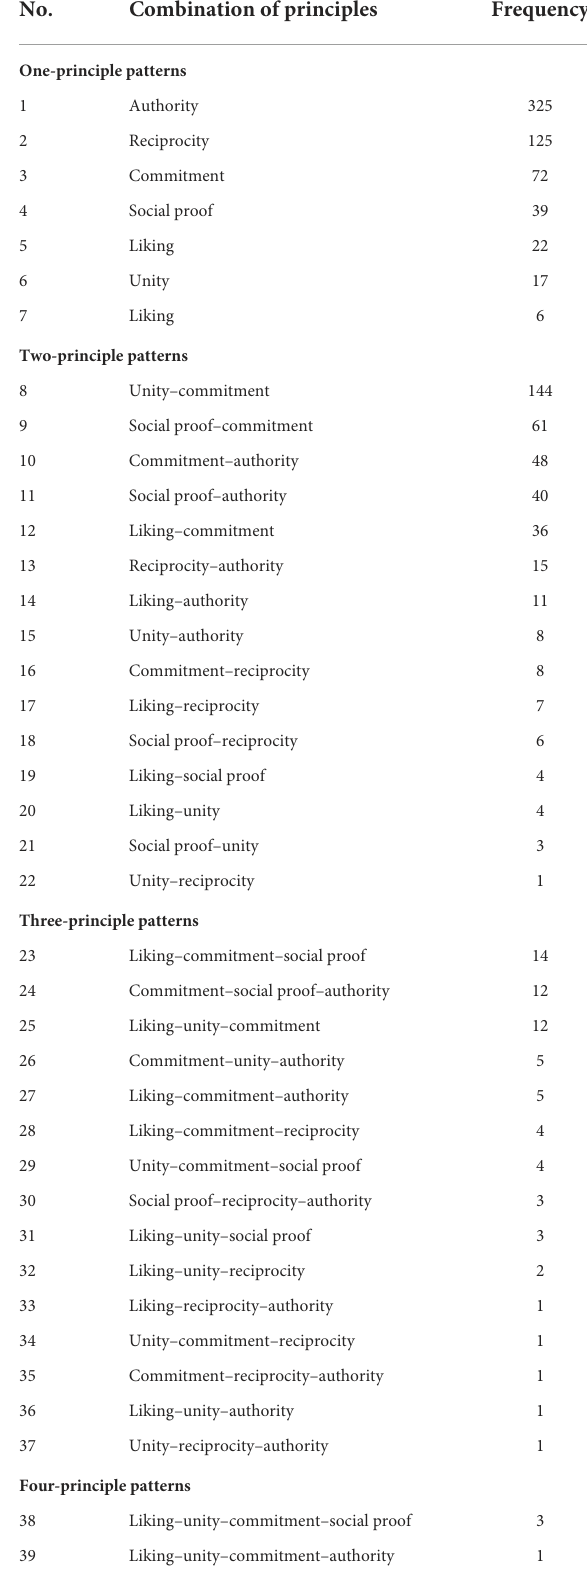
TABLE 5 Patterns of combinations of persuasion principles in MoH